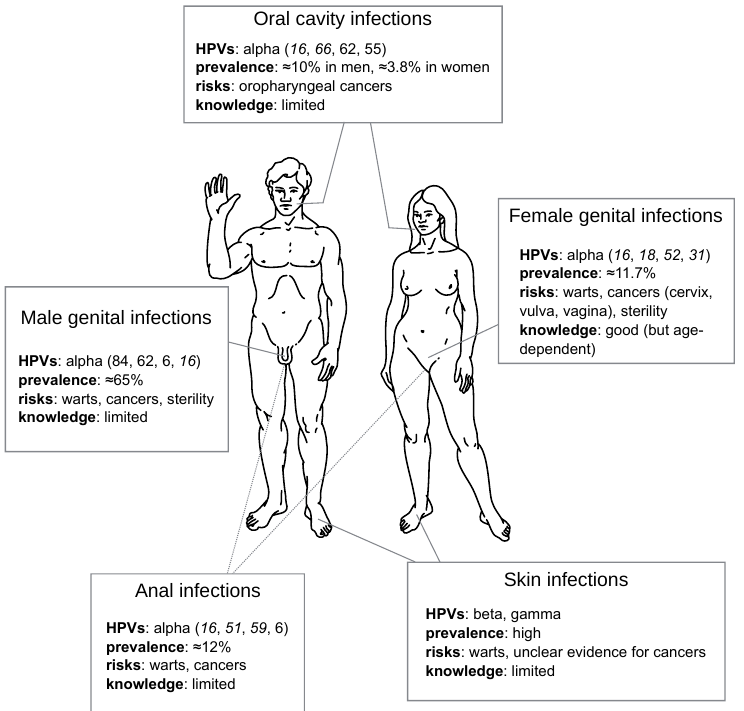
Figure 5. Challenges of HPV acute infections per anatomical location. For each location, HPVs are ordered per prevalence and oncogenic ones are in italic. Most prevalences are global estimates [1,4,107], except for oral (US [108]), genital in men (Brazil, Mexico, US [109]) and anal (Brazil, Mexico, US [110]) sites. Detailed data are available in Supplementary Table